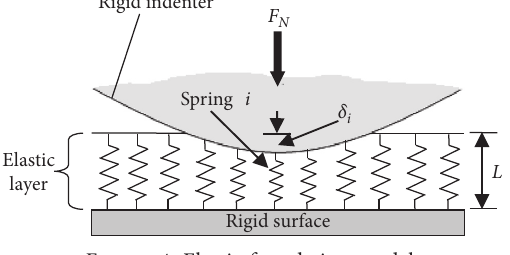
Figure 5: Geometry update schemes for FEM approach. Shifting on surface by moving boundary nodes normal to the